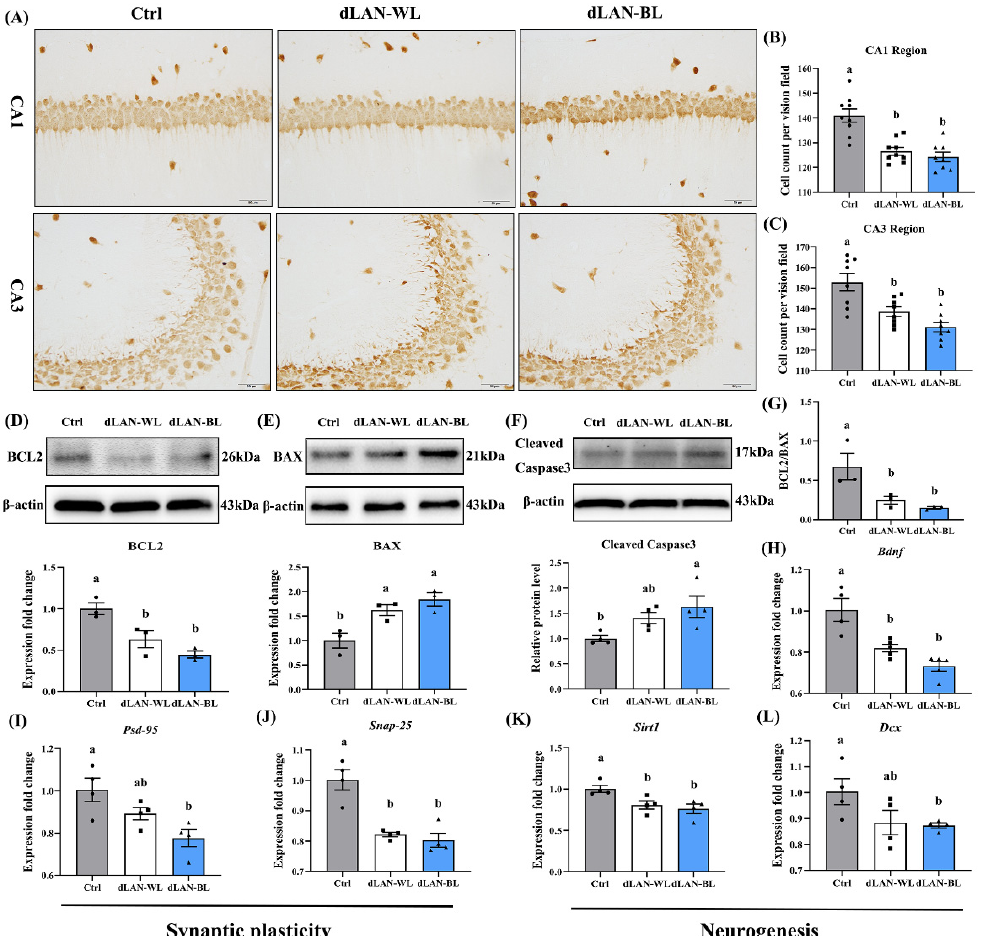
Figure 2. Effect of dim light at night on hippocampal neurons in mice. ( A ) NeuN immunohistochemical staining in the CA1 and CA3 regions of the hippocampus in the different groups. Bar =50 µ m. ( B ) The NeuN-positive cells in the hippocampal CA1 region ( n = 9). ( C ) The NeuN-positive cells in the hippocampal CA3 region ( n = 9). ( D ) Relative protein levels of BCL2 in the hippocampus ( n = 3). ( E ) Relative protein levels of BAX in the hippocampus ( n = 3). ( F ) Relative protein levels of cleaved-caspase3 in the hippocampus ( n = 3). ( G ) The ratio of BCL-2 and BAX protein expression levels ( n = 3). ( H ) The mRNA levels of Bdnf ( n = 4). ( I ) The mRNA levels of Psd95 ( n = 4). ( J ) The mRNA levels of Snap25 ( n = 4). ( K ) The mRNA levels of Sirt1 ( n = 4). ( L ) The mRNA levels of Dcx ( n = 4). Differences were assessed using one-way ANOVA. The result represents the mean ± standard error of the mean. Values not sharing a common superscript letter (a,b) differ significantly at p < 0.05; those with the same letter (a,b) do not differ significantly ( p ≥ 0.05). Ctrl: control group,